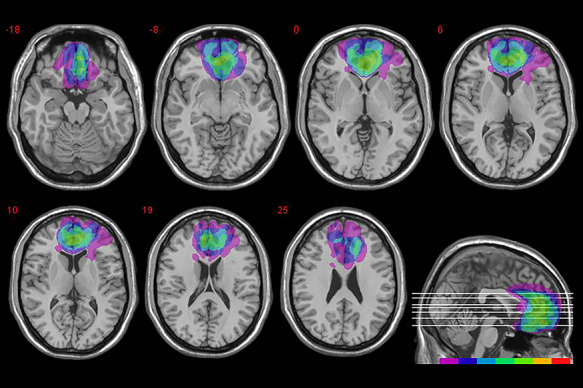
Location and overlap of brain lesions. The panel shows the lesions of the seven patients with vmPFC damage projected on the same seven axial slices and on the mesial view of the standard Montreal Neurological Institute brain. The level of the axial slices is indicated by white horizontal lines on the mesial view of the brain and by z-coordinates. The color bar indicates the number of overlapping lesions. Maximal overlap occurs in BAs 11, 10 and 32 of vmPFC. In axial slices, the left hemisphere is on the left side.